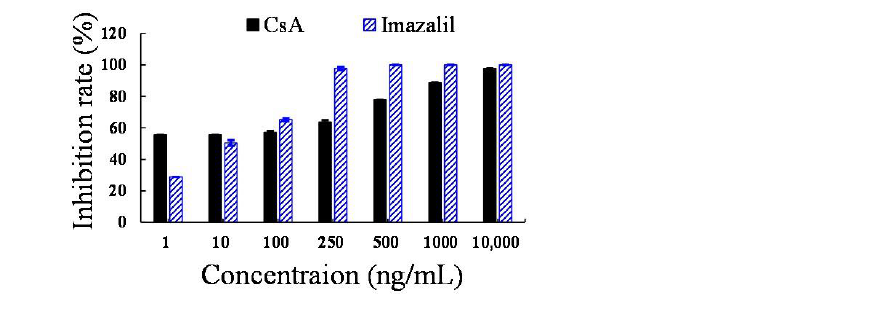
Figure 3. The inhibition rates of cyclosporin A (CsA) and imazalil at different concentrations on the mycelial growth of A. niger after three days of incubation.